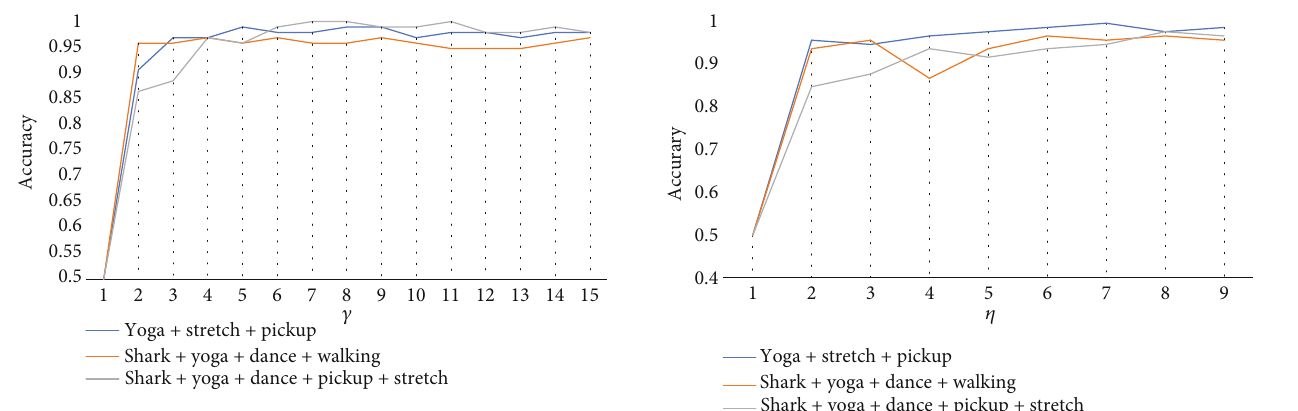
Figure 3: The x -axis represents the value of γ , the y -axis represents the accuracy of segmentation, and the three-colour line graph represents the experiment on three di ff erent datasets.